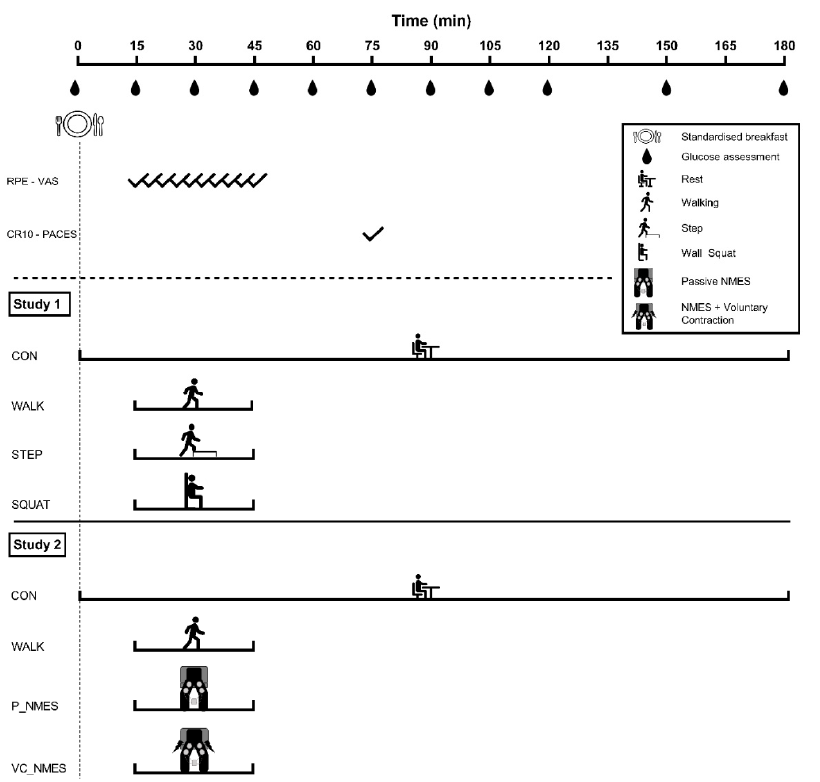
Figure 1. Schematic representation of the two studies. Participants consumed a meal consisting of 1 g of CHO per kg of body weight at the beginning of each visit in both studies. In Study 1, participants performed 30 min of walking (WALK), bench stepping (STEP) or isometric wall squat (SQUAT).